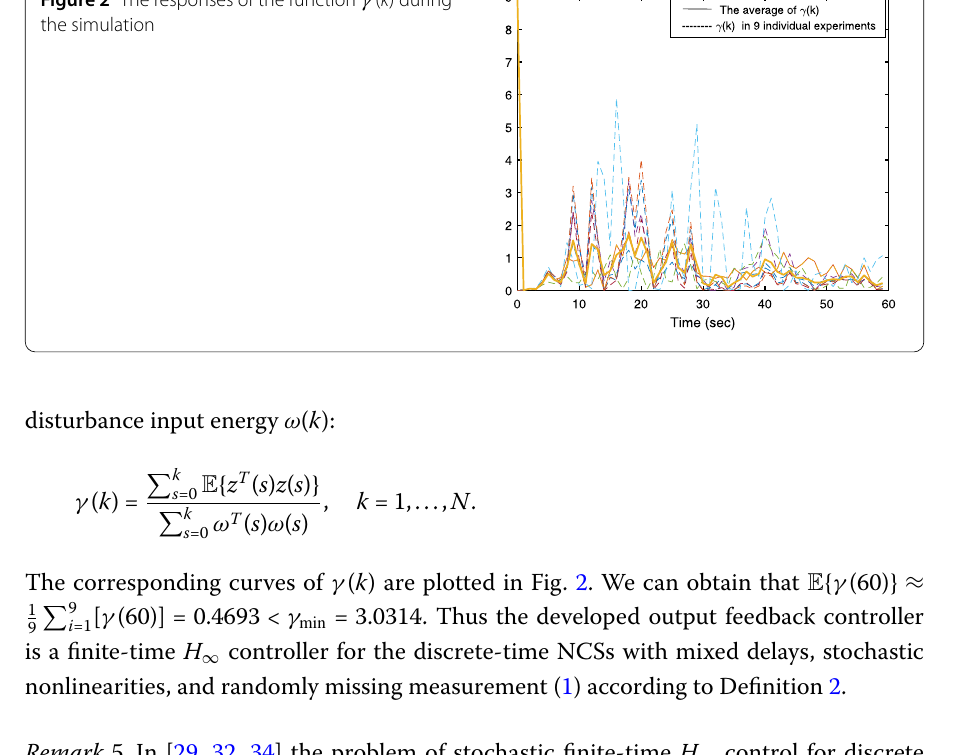
Figure 2 The responses of the function γ ( k ) during the